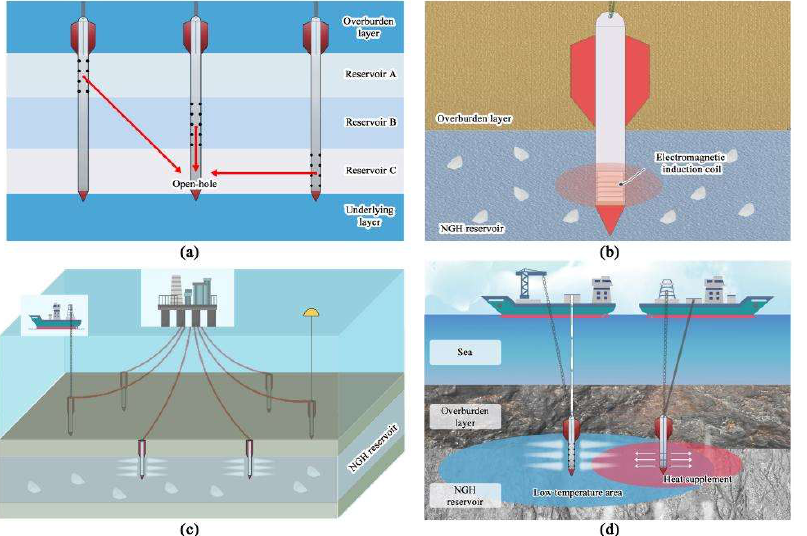
Figure 3. Production enhancement measures: ( a ) open-hole position adjustment; ( b ) inner wall heating; ( c ) clustered depressurization; and ( d ) depressurization combined thermal stimulation.